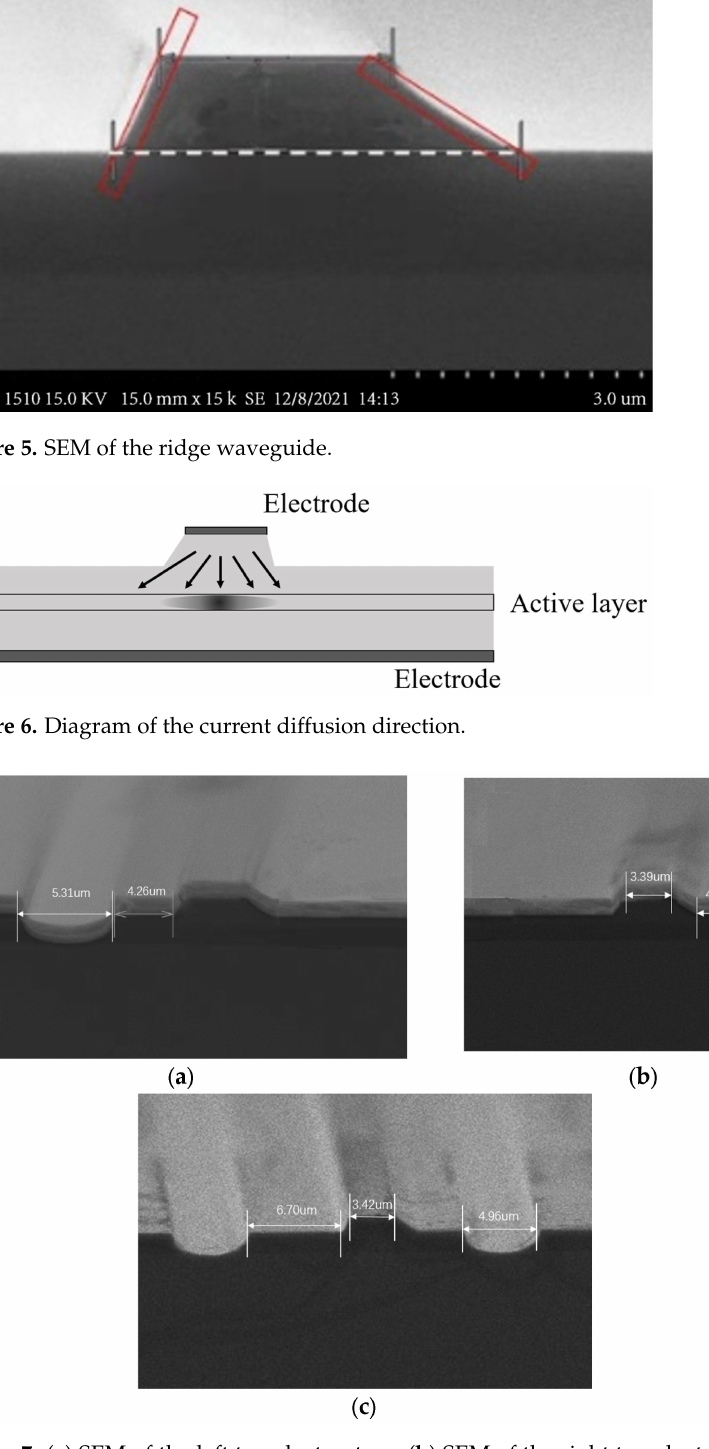
Figure 7. ( a ) SEM of the left trench structure; ( b ) SEM of the right trench structure; ( c ) SEM of the bilateral trench